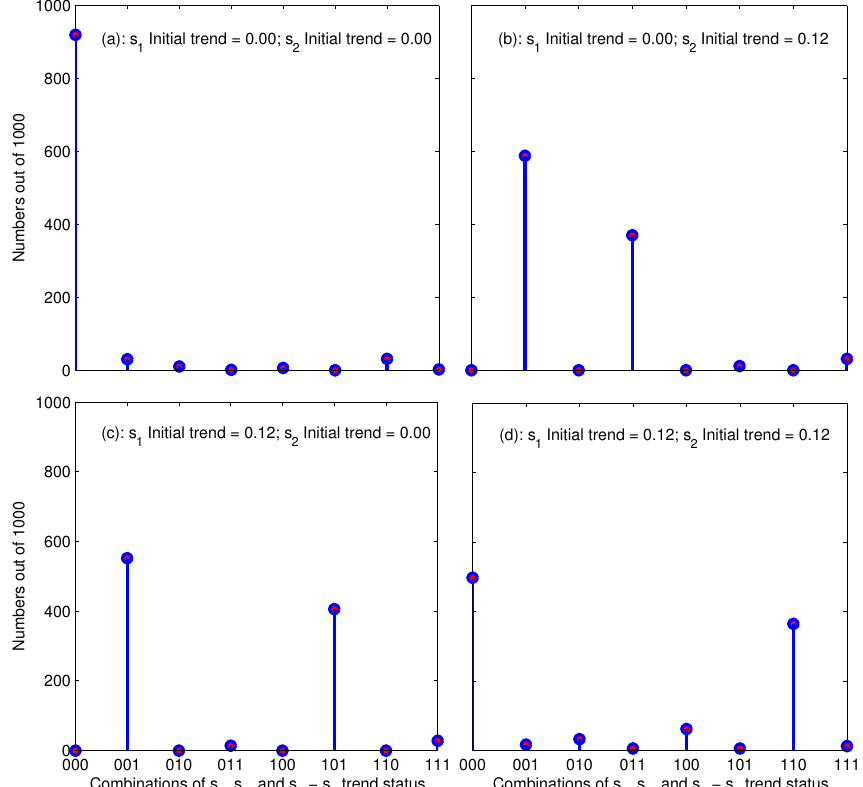
Figure A2. These figures illustrate the frequency of outcomes (shown as the y axis) for four combinations of initial trends for series s 1 and s 2 . The eight possible combinations (shown as the x axis) are represented by 3-bit binary numbers: the first bit represents the s 1 trend status; the second bit represents the s 2 trend status; and the last bit represents the s 1 – s 2 trend status. Each trend status has two possibilities of either a non-significant trend (0) or a significant trend (1). For example, the 001 in the x axis stands for a combination of a non-significant trend (0) in s 1 , non-significant trend (0) in s 2 , and significant trend in s 1 – s 2 (1). Initial trends of s 1 and s 2 were imposed as (a) 0.00 and 0.00; (b) 0.00 and 0.12; (d) 0.12 and 0.00; and (d) 0.12 and 0.12 for each corresponding set of 1000 realizations. The trend units are ◦ C per decade. The y axis represents the number out of 1000 simulations for eight combinations of the s 1 , s 2 , and s 1 - s 2 trend